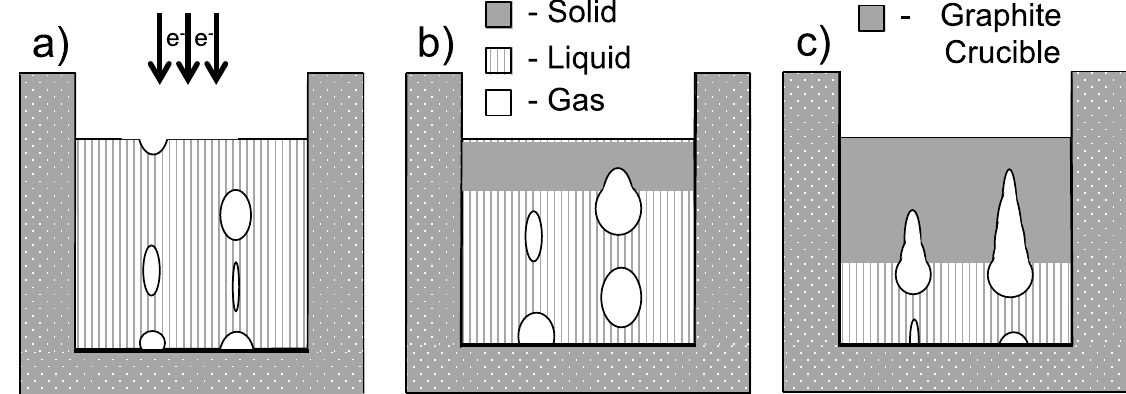
Figure 6. Schematic of the formation of the channel structures in a cooling copper